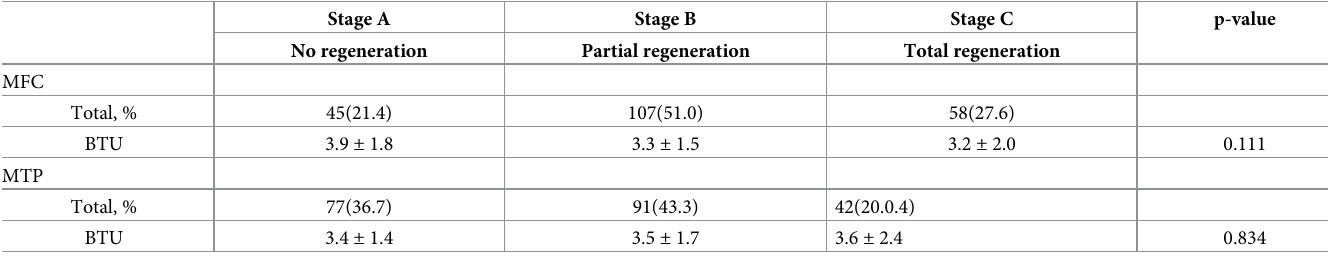
Table 4. Comparison of postoperative BTU (bone tracer uptake) and cartilage